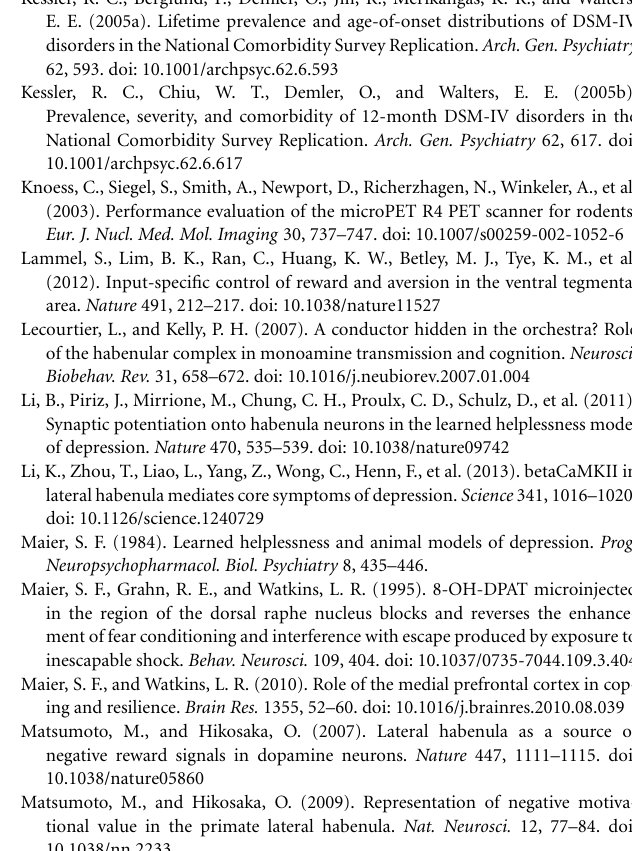
Supplemental Figure 1| Labeled whole-brain ROI template overlaid on T2-weighted rat template. Each of 90 coronal sections are shown, where each region is labeled with the designated abbreviation at (or near) the first time it appears in the whole-brain template (abbreviations given below, most abbreviations designated for a prominent sub-region within ROI following (Paxinos and Watson, 2007); Paxinos and Watson, or named as the abbreviation of the general area). Approximate stereotaxic atlas coordinates are displayed for the coronal planes in each row. Each region is color coded so it can be followed on neighboring coronal